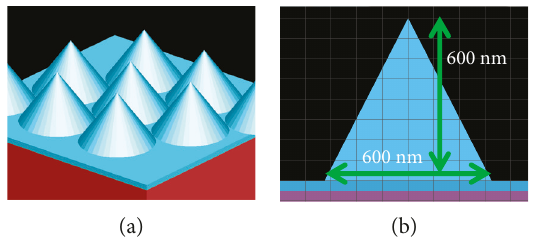
Figure 1: Schematics of simulated NDL on top of c-Si, including (a) top view and (b) cross